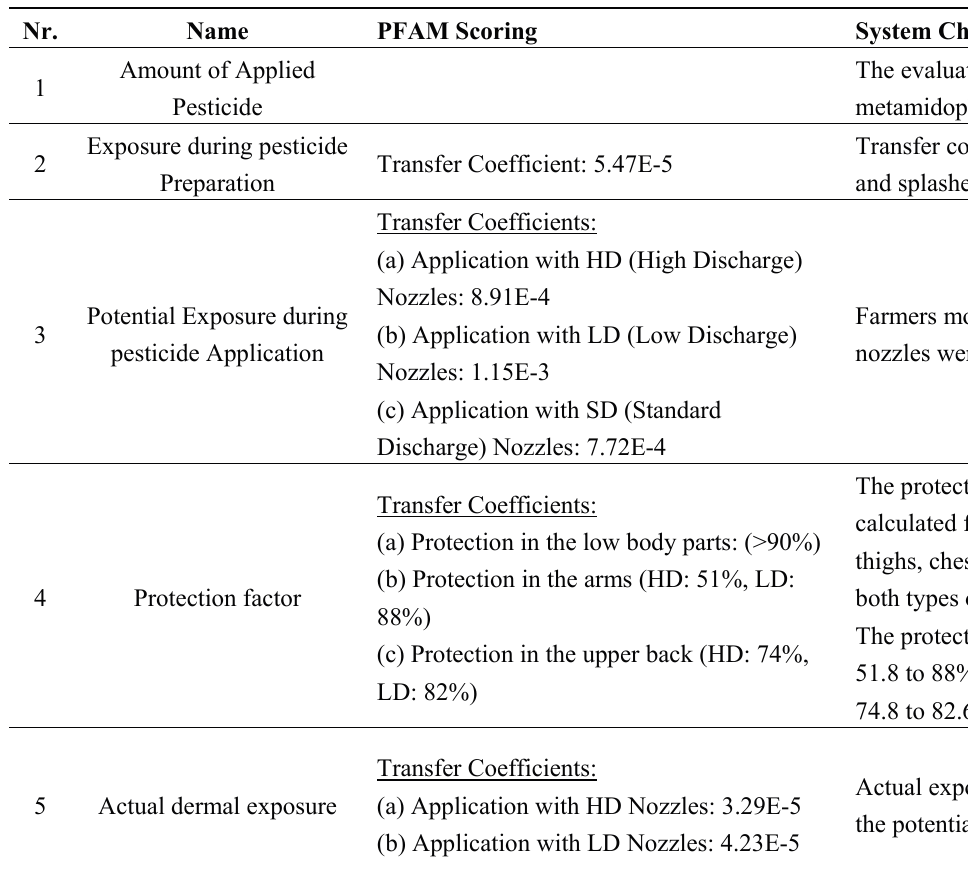
Table A5. PFAM Scoring System for the Case